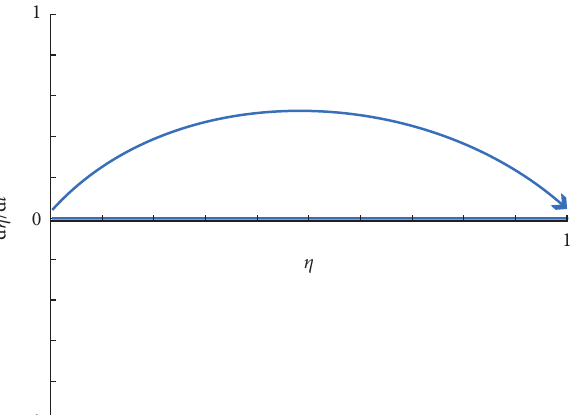
Figure 5: The evolution phase diagram of μ > μ ∗